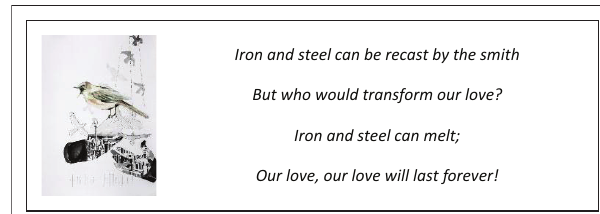
FIGURE 10: Du bist wie eine Blume